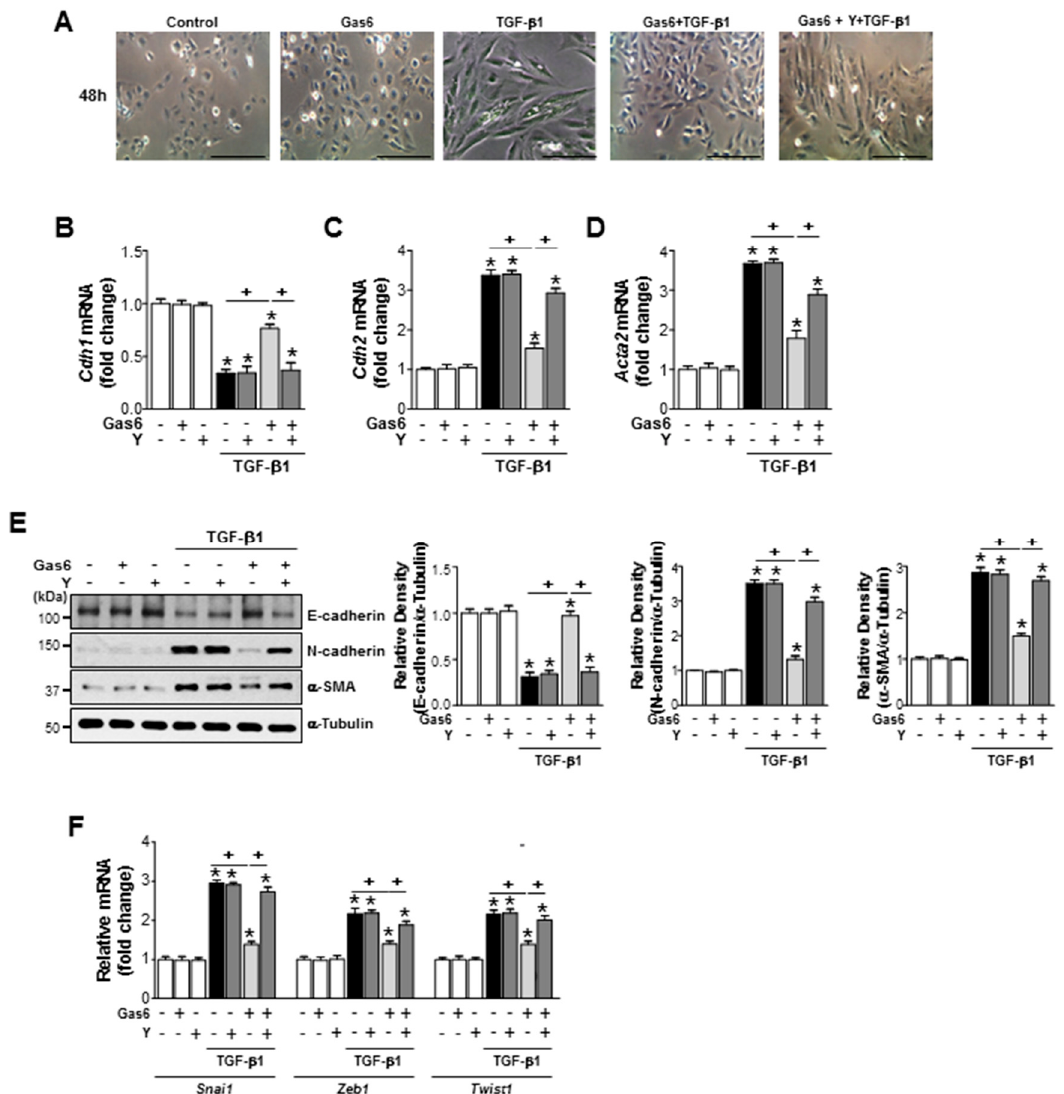
Figure 5. Rho kinase is involved in the Gas6-induced inhibition of EMT in LA-4 cells. LA-4 cells were treated with 30 µ M Y-27632 for 1 h prior to treatment with 400 ng / mL Gas6 for 20 h and then stimulated with 10 ng / mL TGF- β 1 for 48 h. ( A ) Morphological changes in the cells were examined by phase-contrast microscopy (Scale bars = 50 µ m). ( B – D and F ) qPCR analysis of the mRNA levels of EMT markers and EMT-regulating transcription factors. ( E ) Immunoblots of total cell lysates were performed using anti-E-cadherin, anti-N-cadherin, or anti- α -SMA antibodies. Densitometry of the relative abundances of the indicated EMT markers. Alpha-tubulin was used as a control. Values represent the mean ± SEM of three independent experiments. * p < 0.05 compared with control; + p < 0.05, as indicated. Results are representative of three independent experiments.